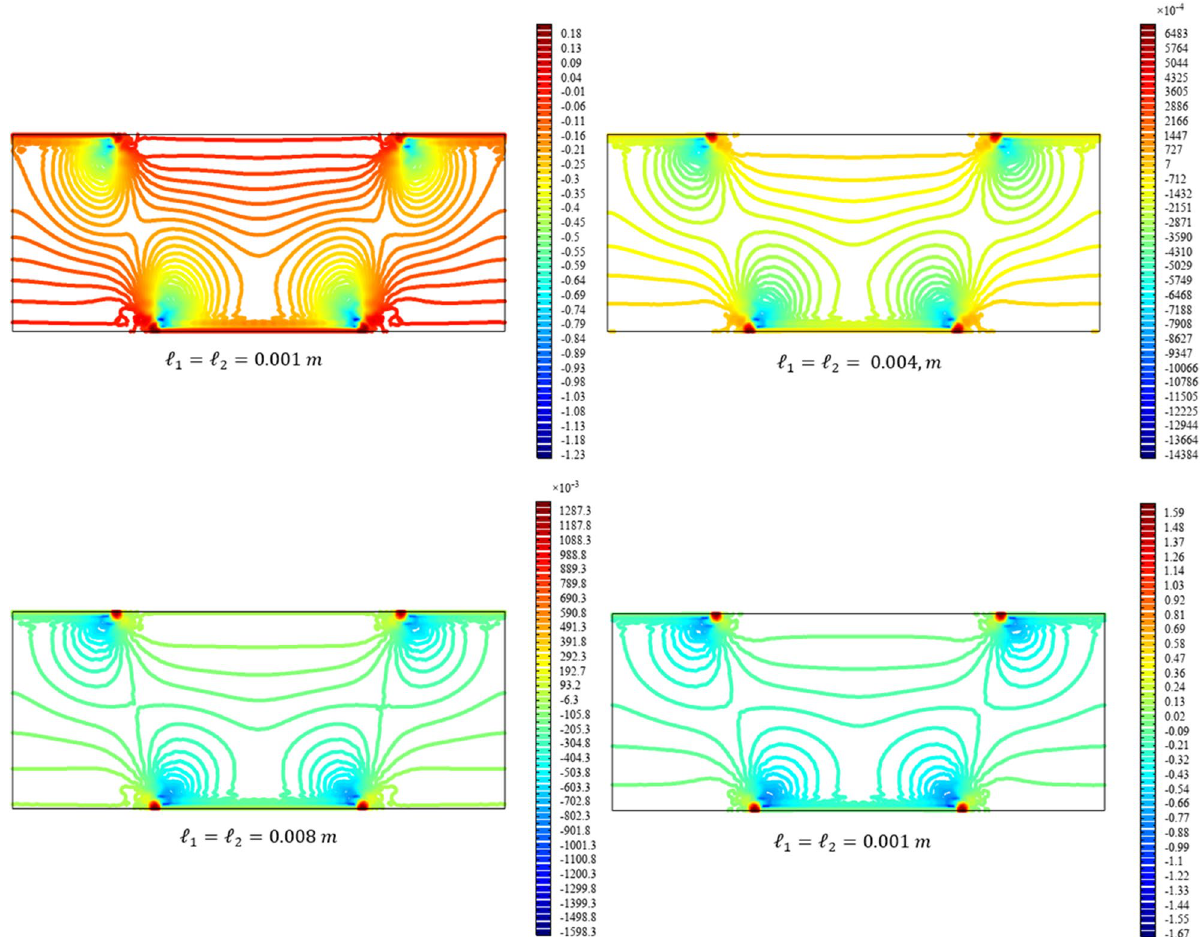
/ s 0 for different values of ℓ 1 and ℓ 2 (COMSOL (cid:30)